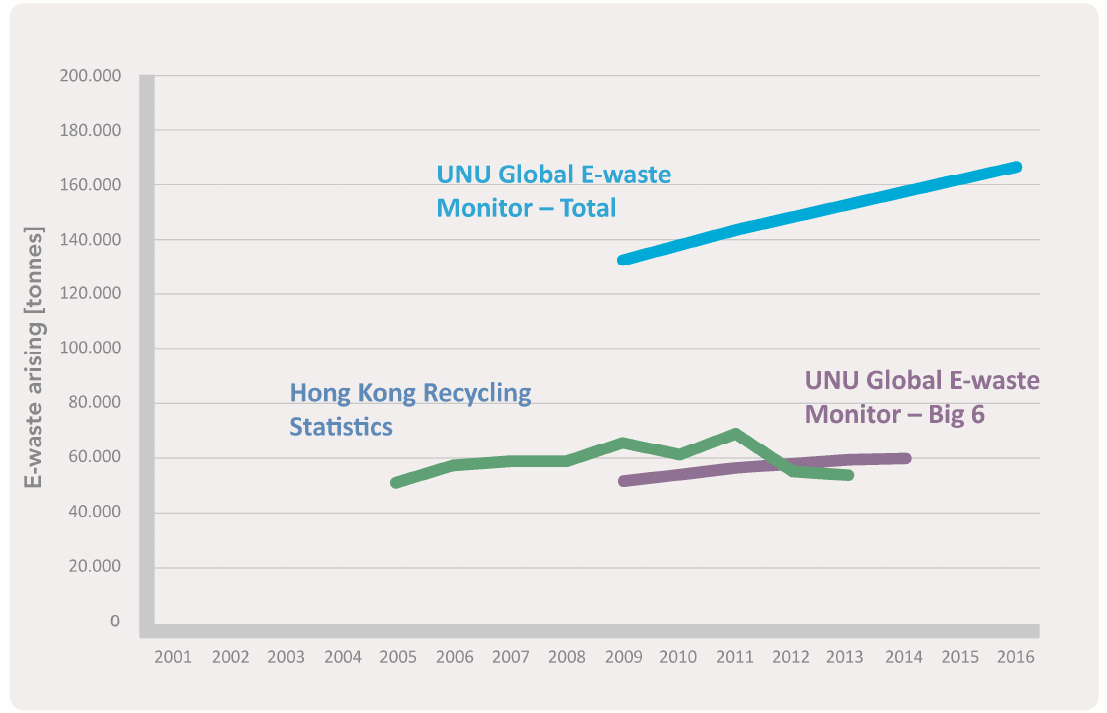
Figure 4. Number of recycled WEEE in Hong Kong between 2004 and 2014 [31], p. 130.